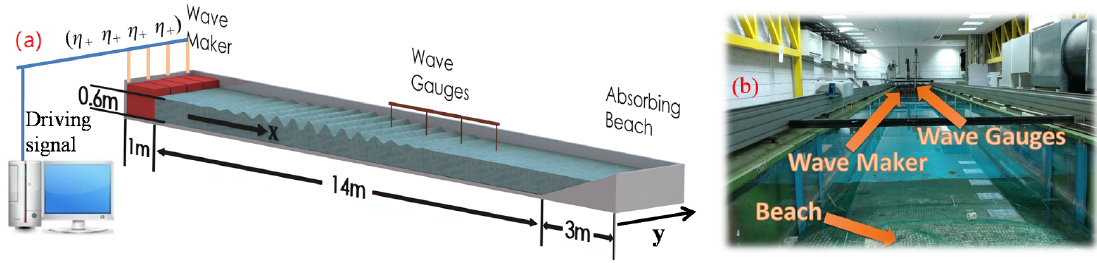
Figure 5. ( a ) Schematic illustration of the experimental setup for generating surface gravity water wave packets ( b ) Photograph of the experimental